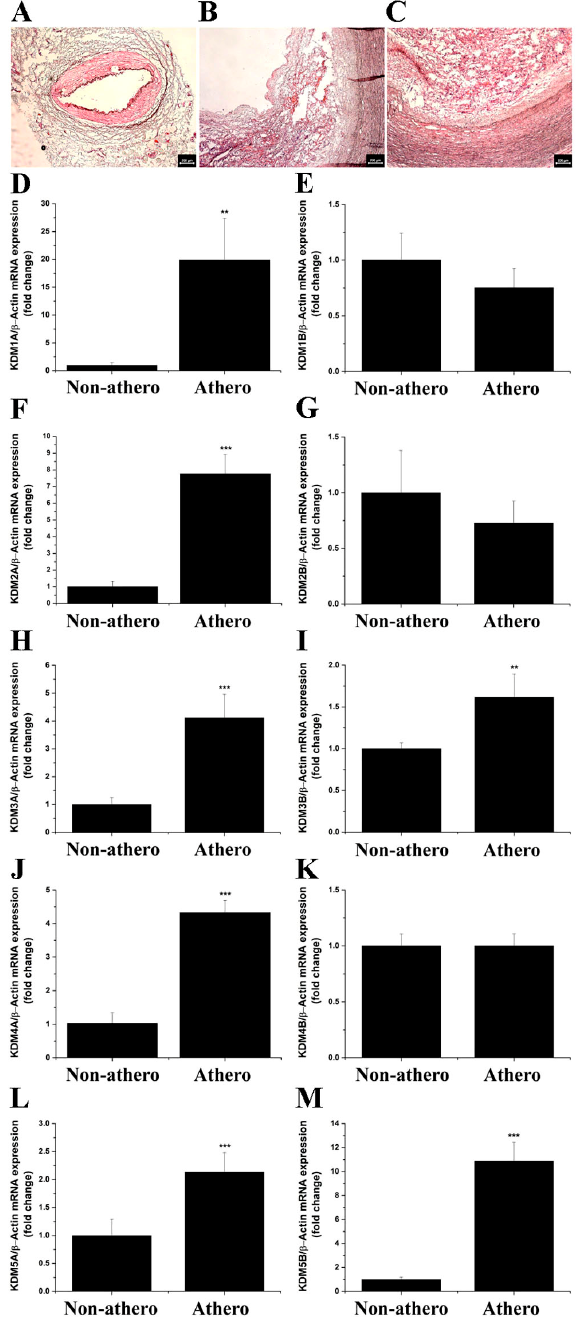
Figure 1. The mRNA expression levels of archetypal KDM subtypes are significantly up-regulated in atherosclerotic human carotid arteries. Representative H&E staining images taken under 5× magnification of ( A ) non-atherosclerotic STA and ( B , C ) carotid artery-derived atherosclerotic sections obtained from a study patient undergoing extended carotid endarterectomy. ( D – M ) Real- time PCR-based gene expression analysis depicting the augmented mRNA levels of LSD1 (KDM1A), KDM2A, KDM3A, KDM3B, KDM4A, KDM5A, and KDM5B in human atherosclerotic lesions. n = 4–9, ** p < 0.01, *** p < 0.001. p -values were taken in relation to non-atherosclerotic condition. Non-athero, non-atherosclerotic specimens; Athero, atherosclerotic specimens.